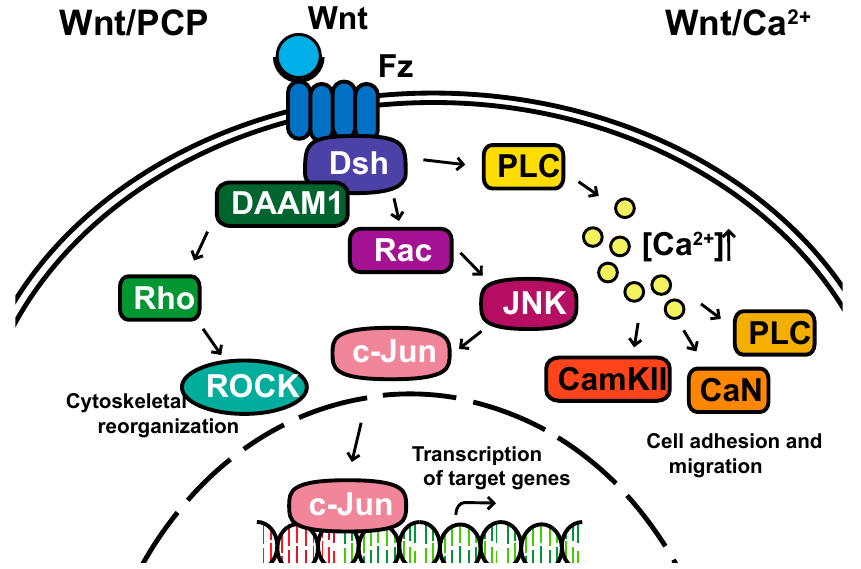
Figure 2. The non-canonical planar cell polarity and Calcium pathways. DAAM1, Disheveled-associated activator of morphogenesis 1; Rac; ROCK, Rho-associated kinase; JNK, Jun kinase; PLC, Phospholipase C; CamKII, calcium/calmodulin-dependent kinase II.